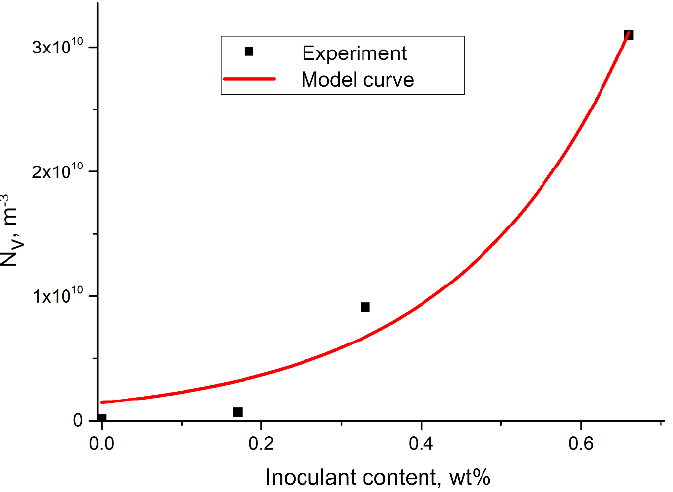
Figure 13. Effect of addition of Fe-Ti inoculant on austenite grain density — the results of experiment and model curve calculated from (3).